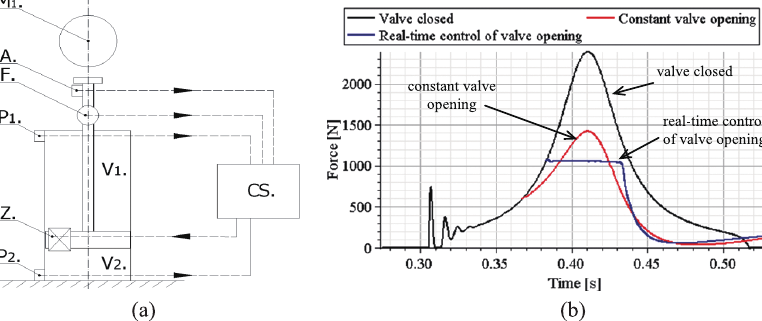
Fig. 17. An adaptive impact absorption system equipped with the Impactometer device a. schema of the proposed system b. numerical example of an impact scenario.